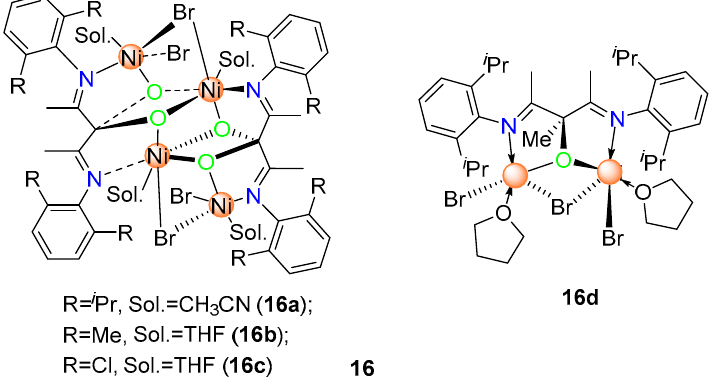
Figure 13. Tetranuclear nickel complexes 16a – c and binuclear nickel catalyst 16d .